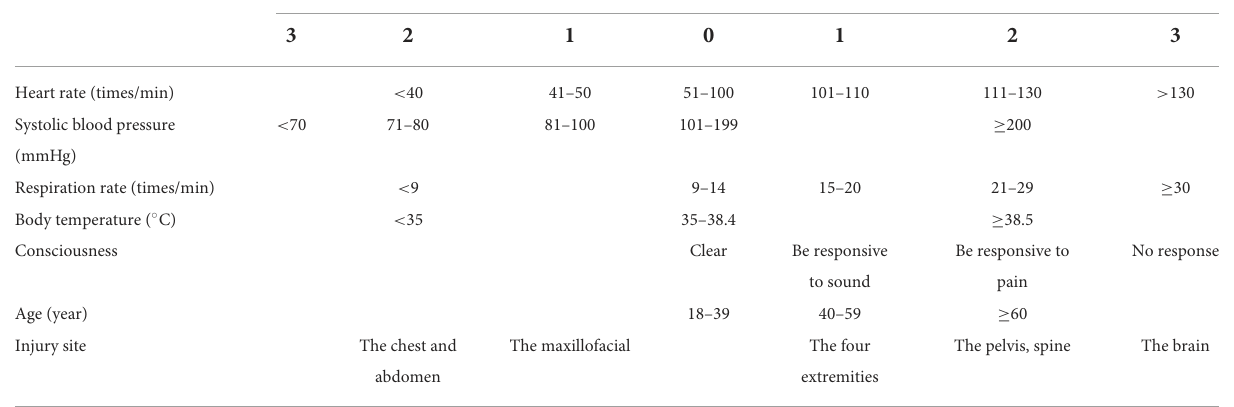
TABLE 1 MEWS combined with age and injury site score.